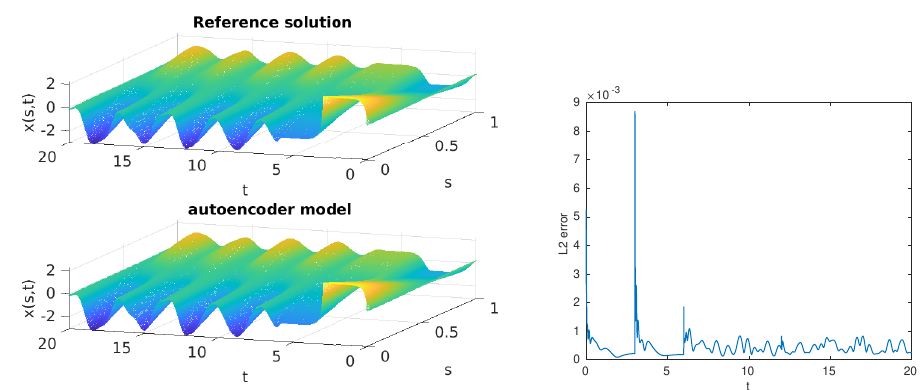
Figure 3. ( Left ): Comparison of the original data set (top) and the approximated one obtained with the trained autoencoder (bottom). ( Right ): Approximation error